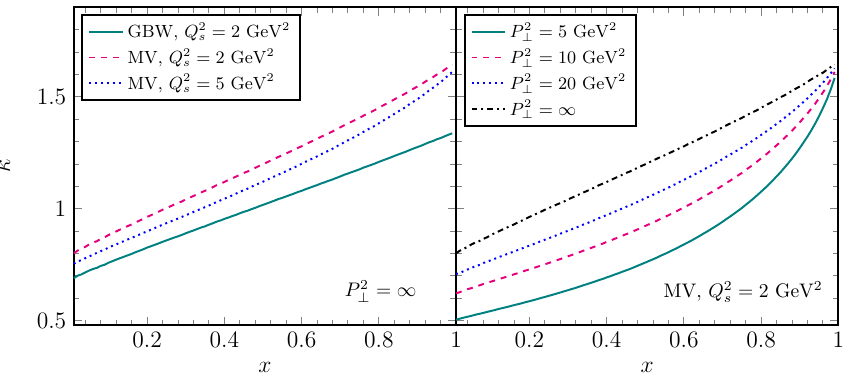
Figure 8 . Left panel: the smooth function κ ( x ) appearing in the integrated Pomeron gluon distribution in eq. (5.19) for the GBW model (for which it is independent of Q s ) and for the MV model for two different saturation scales. Right panel: the reduced Pomeron gluon distribution of eq. (5.23) for various values of P 2 Q 2 = 2 GeV 2 s